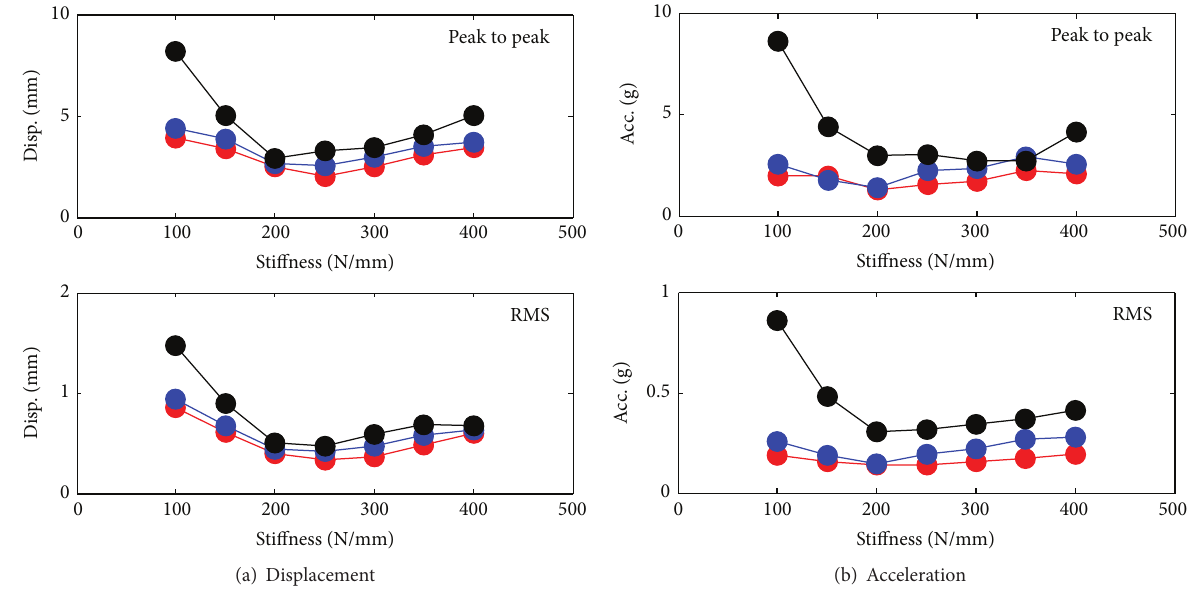
Figure 9: Simulation results of the vehicle vibrations with respect to eight spring stiffness values and three driving speeds of the vehicle. (a) Displacement and (b) acceleration (red, blue, and black lines indicate low, mid, and high speed, resp., and top and bottom figures indicate peak to peak and RMS values, resp.).